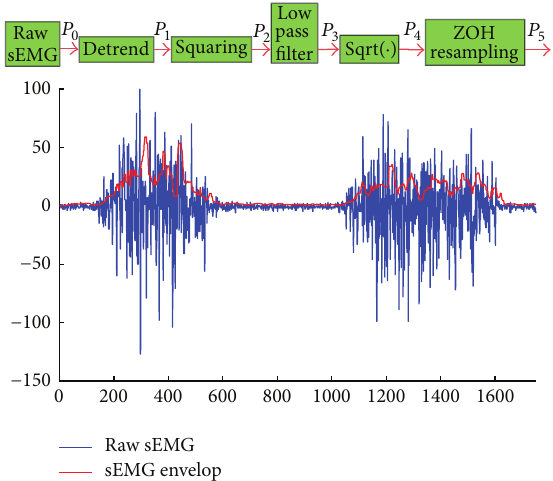
Figure 4: sEMG enveloping procedure based on fast smoothing algorithm and example of sEMG smooth enveloping with sampling rate 200